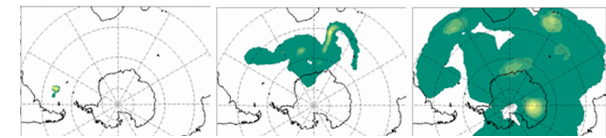
Fig. 3. Total columnar dust concentrations modeled by HYSPLIT Figure 3: Total columnar dust concentrations modeled by HYSPLIT initialized by the active dust initialized by the active dust sources detected by MODIS on 26 sources detected by MODIS on February 26 2005 and emission duration constrained by surface visibility measurements. Outputs are shown for February 27 (left), March 03 (center) and March February 2005 and emission duration constrained by surface visi- 09 (right). Lighter colors indicate higher concentrations. bility measurements. Outputs are shown for 27 February (left), 3 March (center) and 9 March (right). Lighter colors indicate higher concentrations.